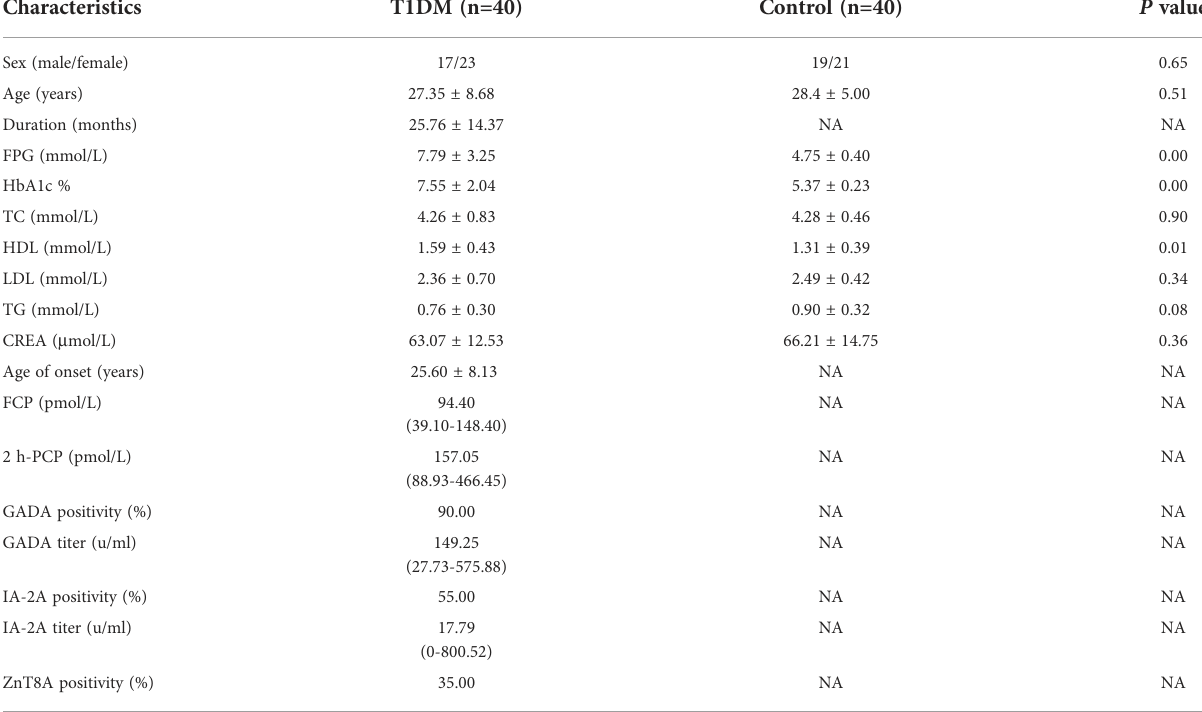
TABLE 1 Detailed information of T1DM patients and control subjects in the validation